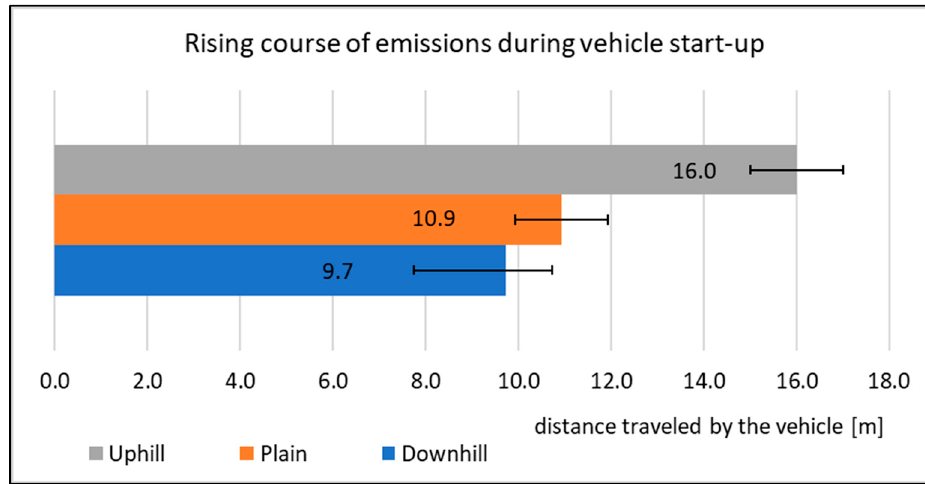
Figure 10. Rising course of emissions during vehicle start-up.